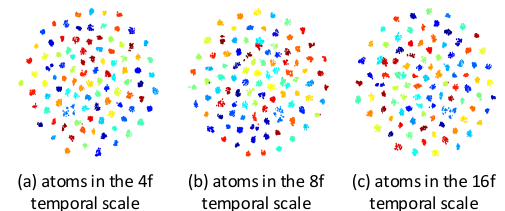
Figure 12. Atoms embedding visualizations of the 4f, 8f and 16f temporal scales on UCF101 training split-1. The averaged atom of each action is visualized as a point and the averaged atoms that belong to the same action class have the same